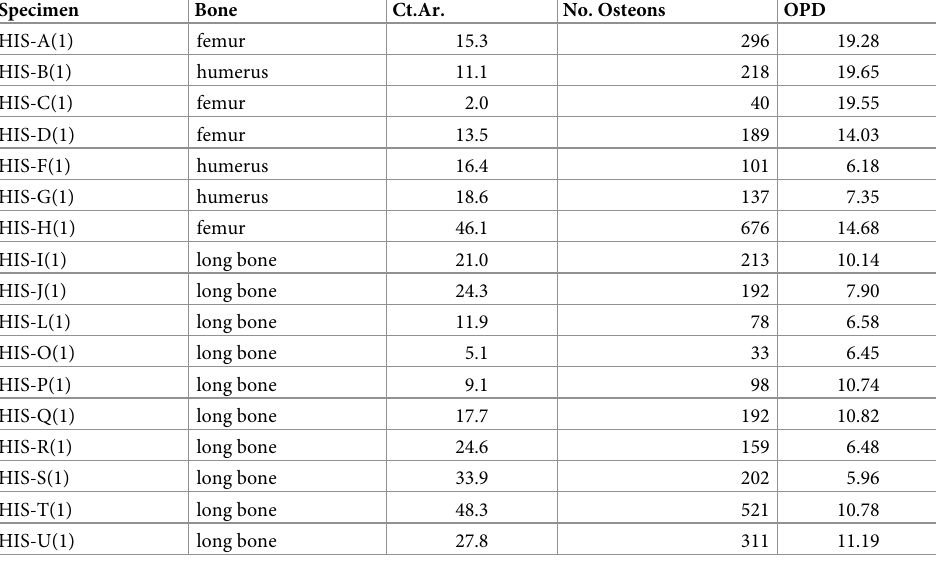
Table 5. Histomorphometric analysis of the Osteon Population Density (OPD) in human specimens from the Tomb of Nestor’s Cup. Specimen Bone Ct.Ar. No.